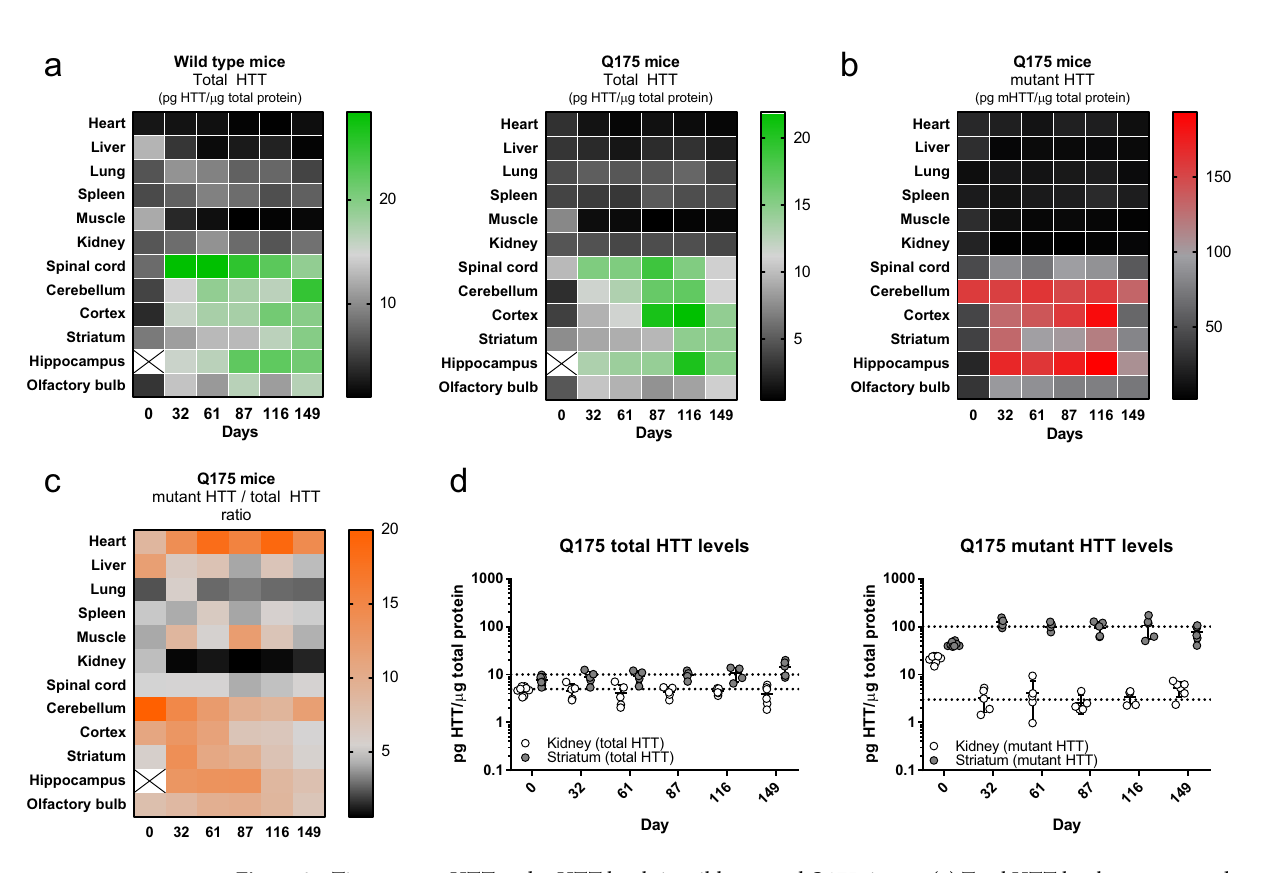
Figure 9. Time-course HTT and mHTT levels in wild type and Q175 tissues. ( a ) Total HTT levels, as measured by the 2B7-MAB2166 SMC assay in different tissues and at different time points, are reported as heat maps for wild type (left) and Q175 KI (right) mice. Each colour represents the average levels of four to six animals. ( b ) mHTT levels, as measured by the 2B7-MW1 SMC assay in different tissues and at different time points, are reported as heat map for Q175 KI mice. Each colour is the average levels of four to six animals. ( c ) The ratio between mHTT and total HTT in Q175 samples is reported for each analysed tissue and time point as heat map. ( d ) Total HTT (left panel) and mHTT (right panel) levels for each animal are presented for the striatum (grey) and kidney (white) of Q175 animals. All numeric values are available in the supplementary material